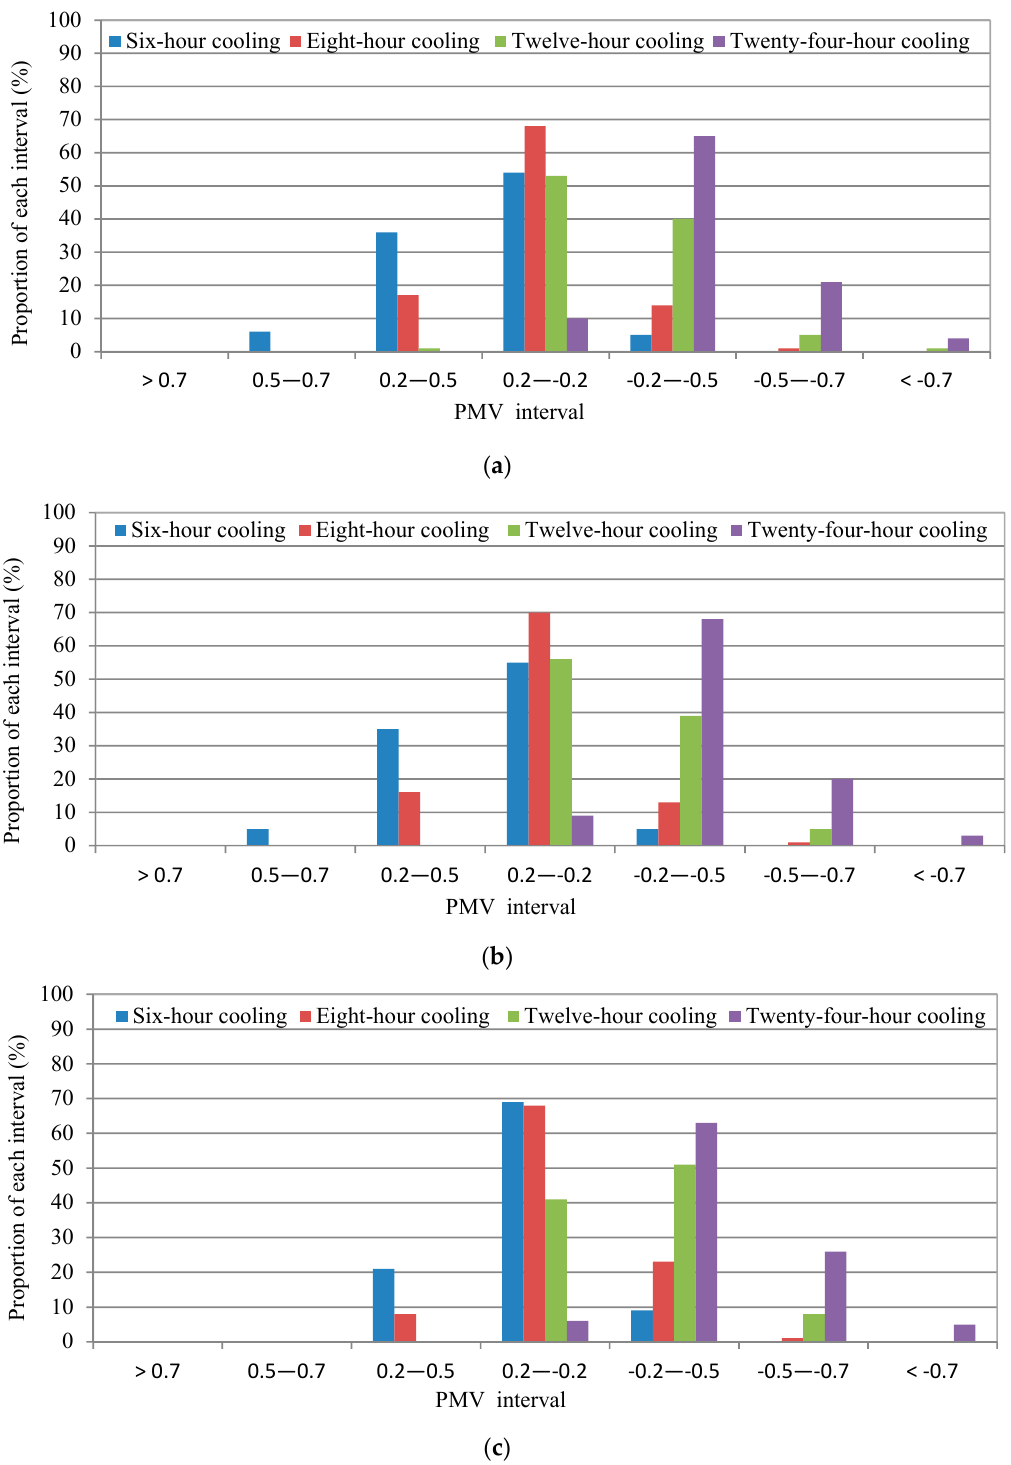
Figure 11. Proportions of time that different predicted mean vote interval occurs throughout the entire period of cooling under various cooling durations. ( a ) Top floor room; ( b ) second floor room; and ( c ) ground floor room.